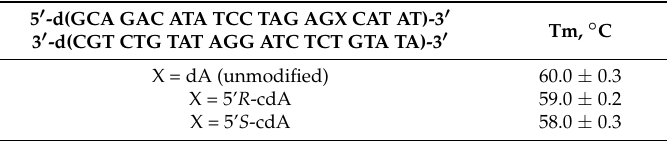
Table 1. Melting points, Tm, of 23-mer DNA